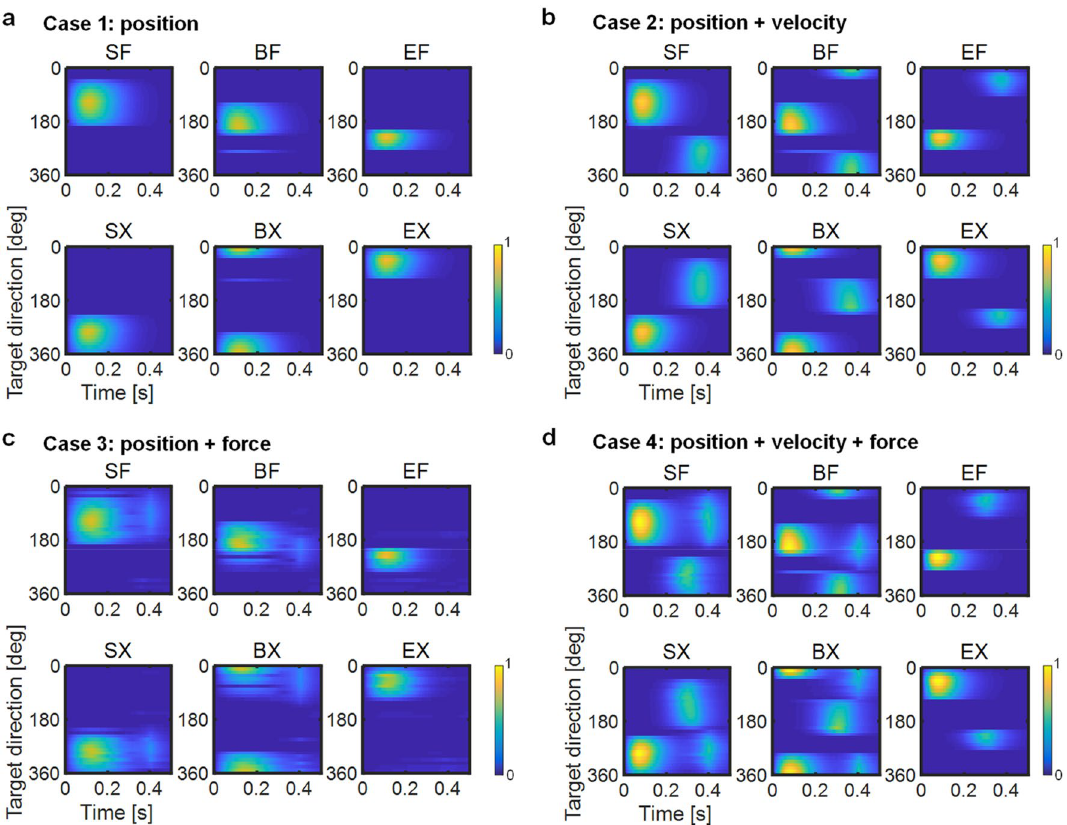
Figure 3. Muscle activation patterns plotted as a function of time and target direction. The target direction is counter-clockwise from the right. Cases 1–4 are shown in ( a )–( d ), respectively. Values are normalised using the highest activation level in each muscle across all cases. Muscle activation levels were normalised by the highest activation level in each muscle across all cases: SF, 0.32; SX, 0.35; BF, 0.24; BX, 0.23; EF, 0.28; EX, antagonist muscles synchronising with the biarticular muscles BF or BX. In Case 3, the agonist muscles were activated twice, similar to bursts of AG1 and AG2 (Figs. 3c, 4g). The second activations might suppress the devel- opment of hand force and joint torques at the end of movement. Muscles EF and EX were weakly activated to supplement BF or BX. In Case 4, muscle activations showed a triphasic pattern resembling the superposition of activations in Cases 2 and 3, such that the agonist and antagonist muscles were activated in an alternating man- ner; however, the agonist muscles were occasionally activated twice (Fig. 3d). Notably, when the SF muscle acted as an agonist (e.g. 90° movement direction; Fig. 4h: left), it was activated twice, at the start and end of move- ment; it was activated only once in the middle of movement when it was an antagonist muscle (e.g. 270° move- ment direction; Fig. 4h: right). The later activation of agonist muscles may contribute to movement stabilisation because the later torque observed in Case 2, which the antagonist muscles generated, may induce unnecessary movement after reaching the target. Thus, the additional torque generated by the agonist muscles was required to counteract opposite torques and stabilise movement after completing the task. The costs of the position, velocity, and force corresponded to AG1, ANT, and AG2, respectively. Thus, Case 4 could only reproduce the triphasic muscle activation pattern.